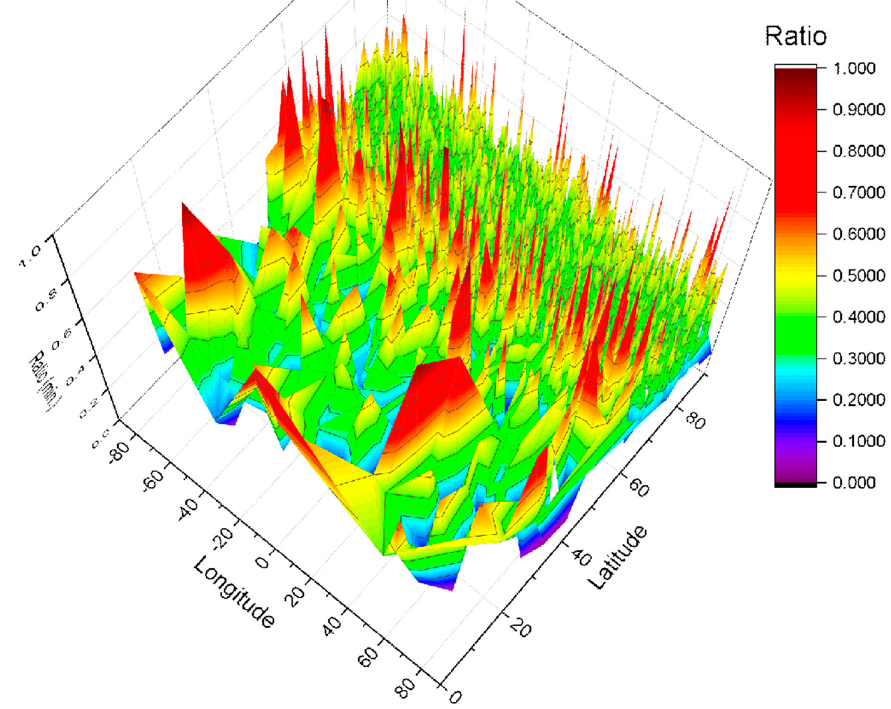
Figure 5. A heliographical distribution of the flare’s ratio index for our period of study.